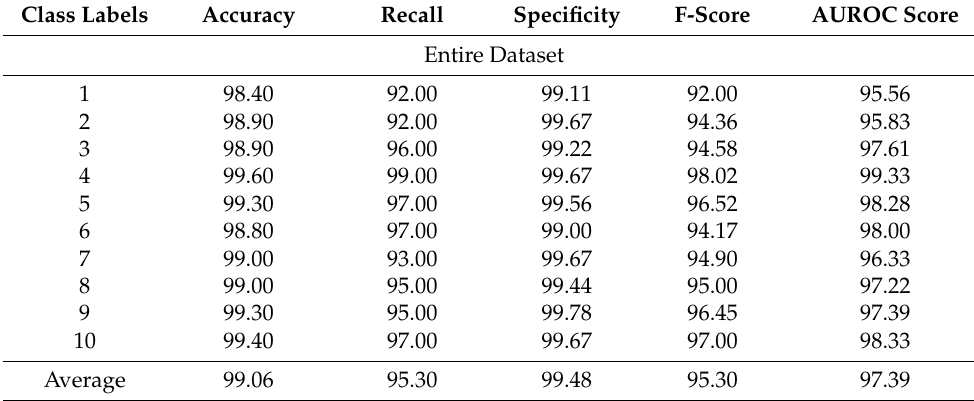
Table 5. HAR outcomes of QWSA-HDLAR model on UCF Sport dataset. Class